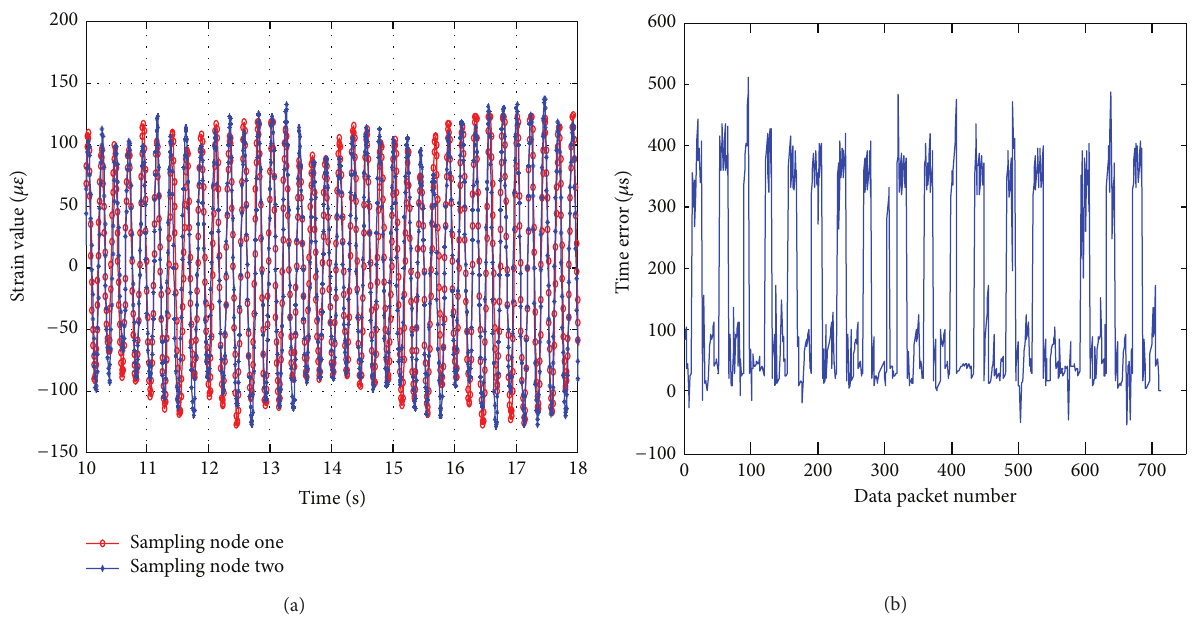
Figure 17: Time synchronization error of 128 Hz: (a) time history signal and (b) time